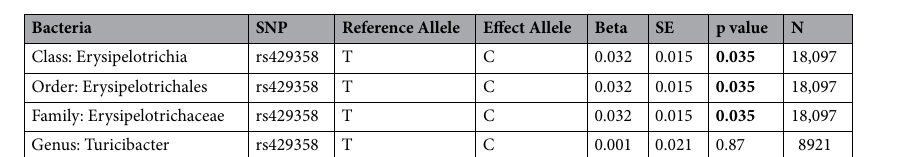
Table 3. Bacteria in the Erysipelotrichia phylogenetic branch are nominally associated with rs429358 in humans. The positive beta values reflect that the bacterial taxa are increased with the minor APOE4 allele of rs429358. These results combine data from men and women and are supplemental data from a large microbiome genetics study 42 . Significance p values are in bold font.